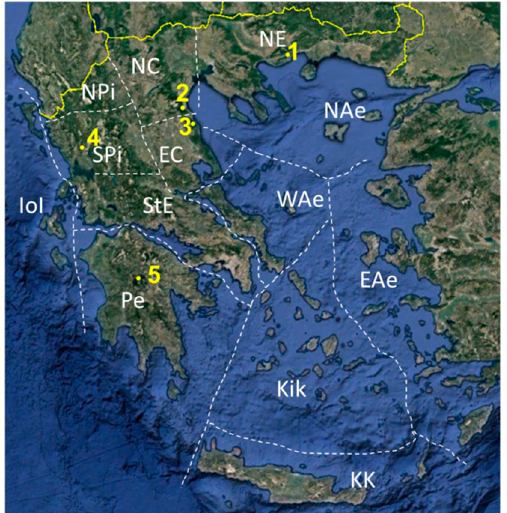
Figure 1. Map of Greece showing the five collection sites of the oregano ( Origanum vulgare subsp. hirtum ) seed and the distinct floristic regions of Greece, as these are designated in Flora Hellenica , adapted from Strid and Tan [30]. Site 1: Panagia-Kavala 40°53’ N 24°14’ E, North East (NE), Site 2: Litochoro-Pieria 40°5’ N 22°29’ E, North Central (NC), Site 3: Omolio-Larisa 33 o 53’ N 22 o 38’ E, East Central (EC), Site 4: Papadates-Thesprotia 39°19’ N 20°47’ E, South Pindos (SPi), Site 5: Vytina-Arcadia 37°39’ N 22°12’ E, Peloponese (Pe). [31] Google.